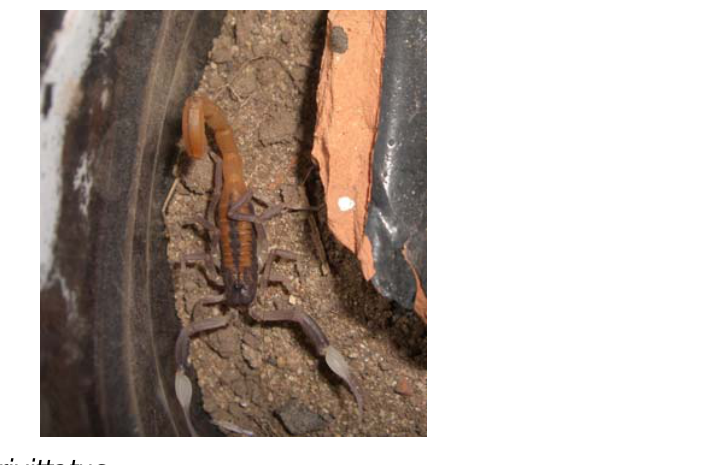
Figure 5. Male of Tityus trivittatus .